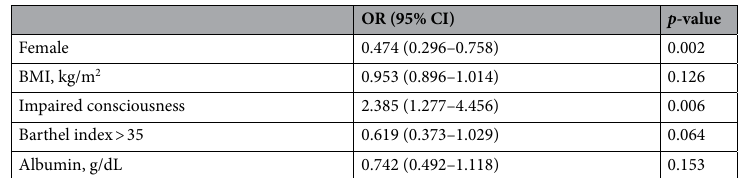
Table 4. Multivariate logistic regression analysis of the baseline characteristics associated with posterior- predominant distribution. CI, confidence interval; eGFR, estimated glomerular filtration rate; OR, odds ratio.